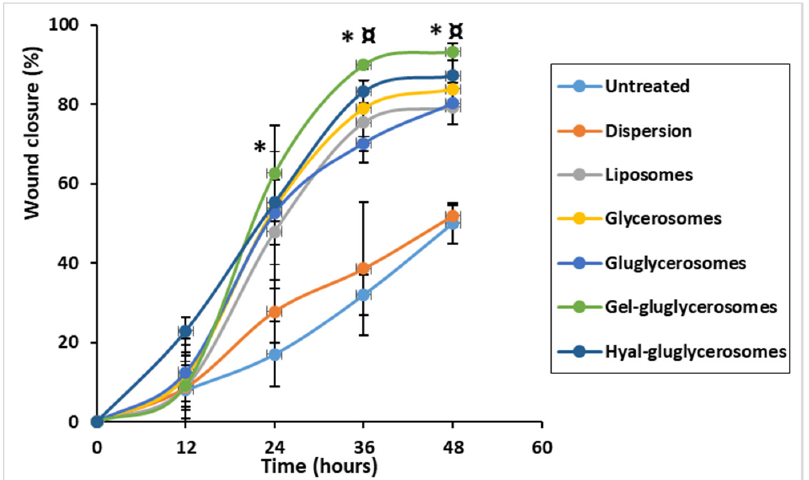
Figure 8. Percentage of wound closure. Wound healing is expressed as percentage of closure relative to the original size of wound. Mean values ± standard deviations are reported. The symbol (*) indicates values significantly different from that of untreated keratinocytes (control) and keratinocytes treated with the extract dispersion at 24, 36, and 48 h . The symbol (¤) indicates values significantly different from that of cells treated with gel-gluglycerosomes and other formulations.